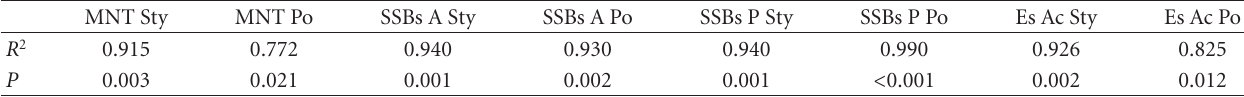
Table 7: Results of the regression between the DI and the results of four cytological tests of coral samples at six natural coral reef sites. MNT: micronucleus test. SSBs: − log single-stranded DNA breaks test where A stands for Acridine orange stained samples and P for PicoGreen stained samples. Es Ac: esterase activity test. Sty: Stylophora pistillata , and Po: Pocillopora damicornis . –log 10 of the results was tested for the correlations. R 2 and P are given for the correlation of each test result with the DI at six sites (IUI, UO, JG, NR, NB, and